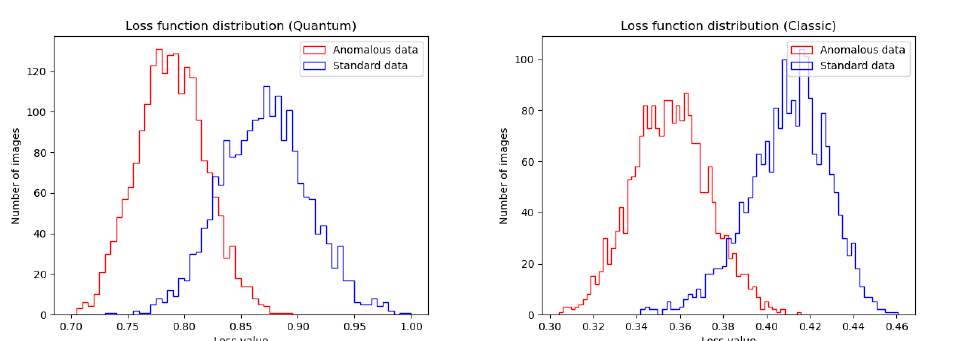
Figure 8. Loss function values distribution for the quantum anomaly detection algorithm ( left ) and the classic counterpart ( right ). The graphs were made using 2000 normal data images (decays that happened just as the particle entered the detector) and 2000 anomalous data images (decays that happened after the particle had traveled inside the